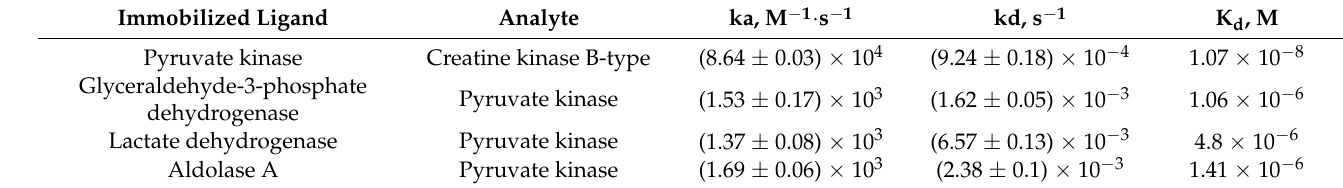
Table 2. Biosensor validation of the interaction of selected proteins with pyruvate kinase.